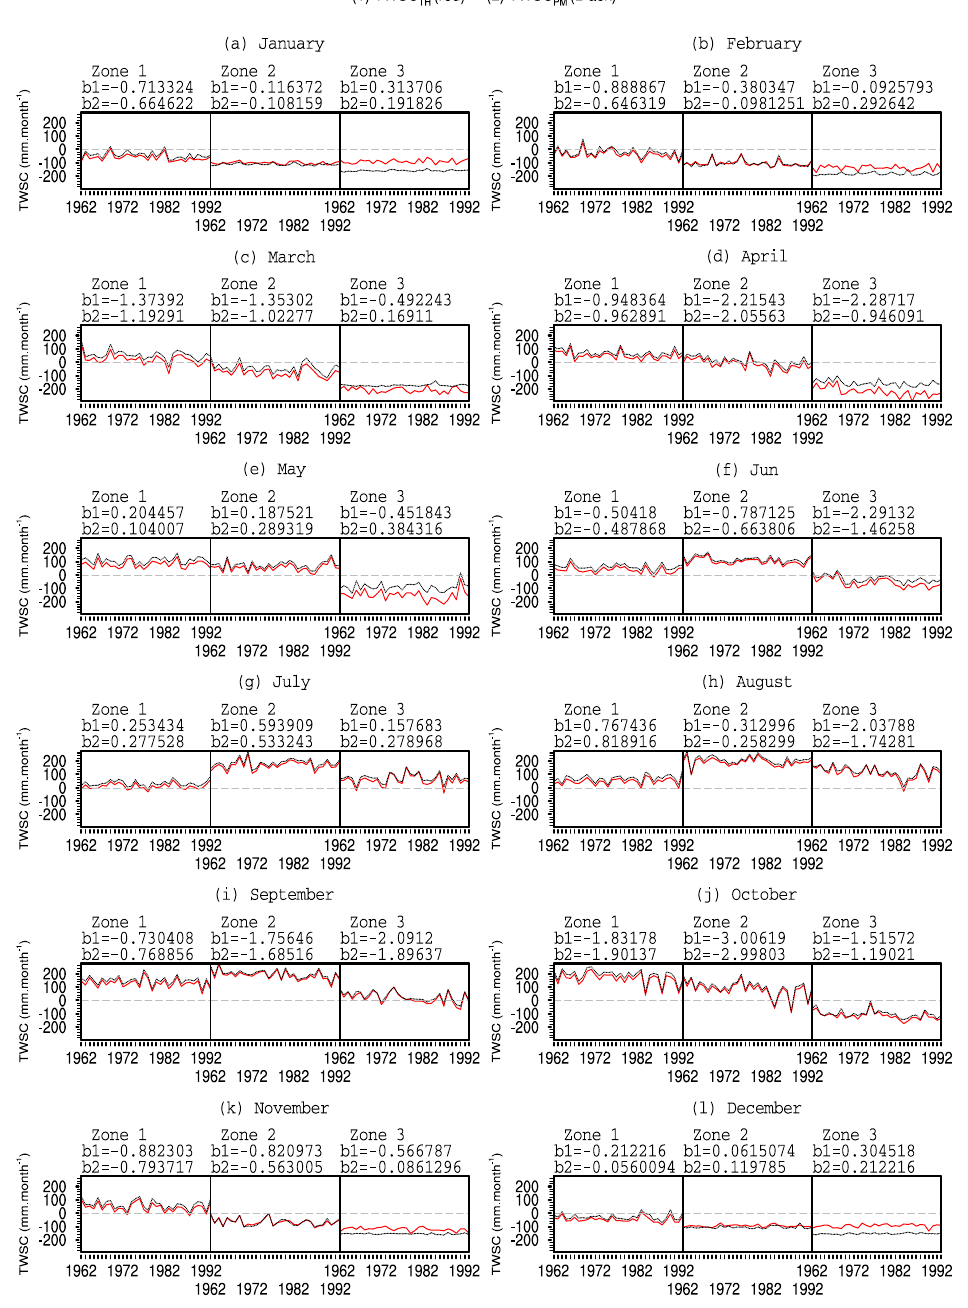
Figure 10. Time series of mean TWSC (expressed in mm · month − 1 ) for each month ( a – l ) of the year and for each zone, calculated using PET obtained from the Thornthwaite and Penman–Monteith methods: for the Equatorial forest zone named Zone 1 (south of study area); for the transition zone between the Equatorial forest zone and the Sahel zone named Zone 2; and for the Sahelian zone named Zone 3 (north of study area). The trend coefficients are indicated by b1 and b2 for TWSC TH and TWSC PM ,